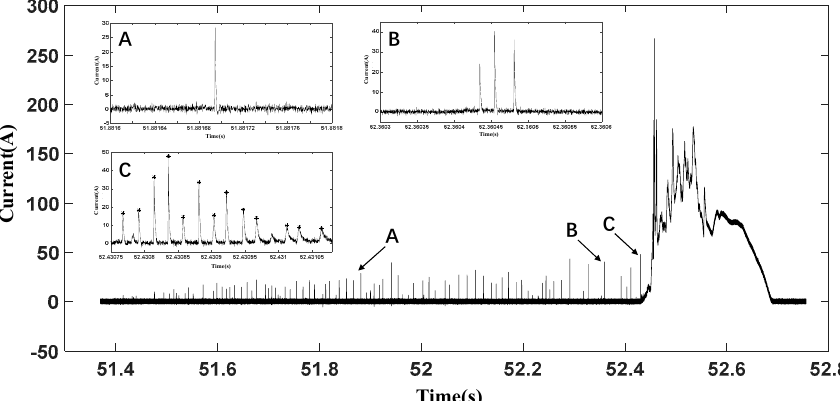
Figure 2. Current waveform and partially enlarged view during the initial stage of triggered lightning 370. ( A ) Enlarged waveform of a precursor current pulse (PCP). ( B ) Enlarged waveform of a PCP cluster. ( C ) Enlarged waveform of an initial precursor current pulses (IPCPs).